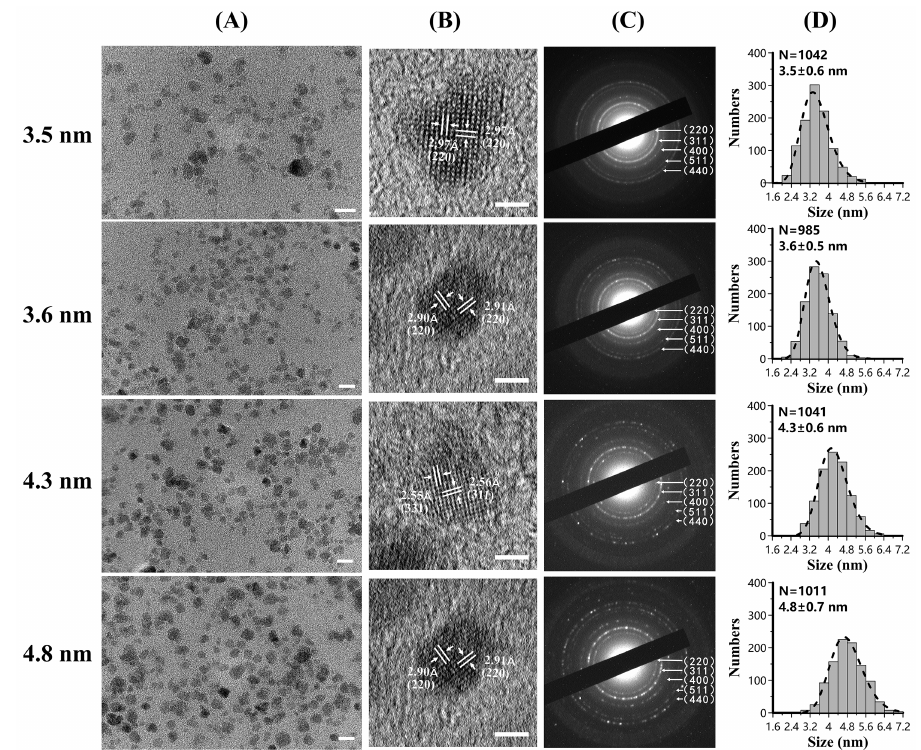
Figure1. Transmissionelectronmicroscopy(TEM)characterizationforsynthesizedMHFnnanoparticles. Column ( A ). low resolution TEM images. Scale bar: 10 nm. Column ( B ). high resolution TEM images. Scale bar: 2 nm. Column ( C ). selected area electron di ff raction images. Column ( D ). size distribution. N, number of particles measured. Dotted line is the lognormal distribution